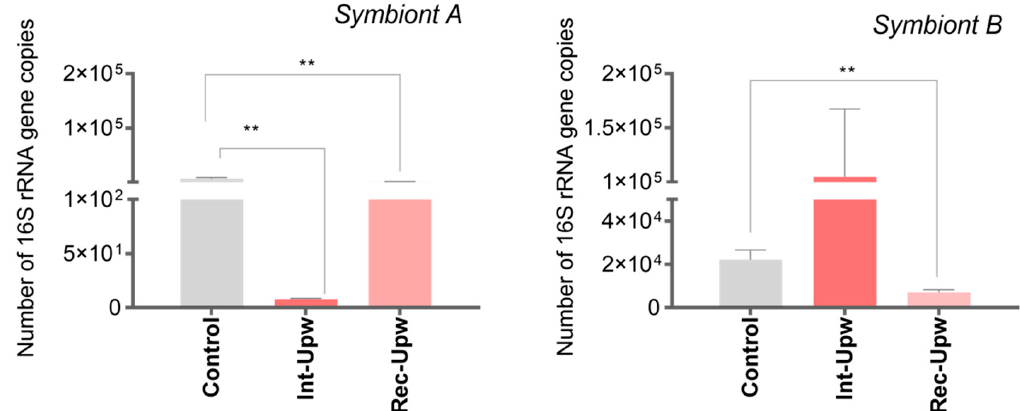
Figure 5. Abundance of Campylobacterota symbionts A and B in scallop gills exposed to upwelling intensification. Abundances are expressed as number of bacterial 16S rRNA gene copies in scallop gills exposed to upwelling intensification (Int-Upw: 10.83 ± 0.08 ◦ C, pH 7.56 ± 0.02, 4.22 ± 0.08 mL O 2 L − 1 ) and recovery (Rec-Upw: 14.78 ± 0.01 ◦ C, pH 8.0 ± 0.02, 6.72 ± 0.11 mL O 2 L − 1 ). Values are represented as the mean ± SE and asterisks indicate significant differences compared with control scallops (absence of upwelling—Control: 15.0 ± 0.01 ◦ C, pH 8.0 ± 0.02 and 7.0 ± 0.1 mL O 2 L − 1 ) (** p < 0.005).